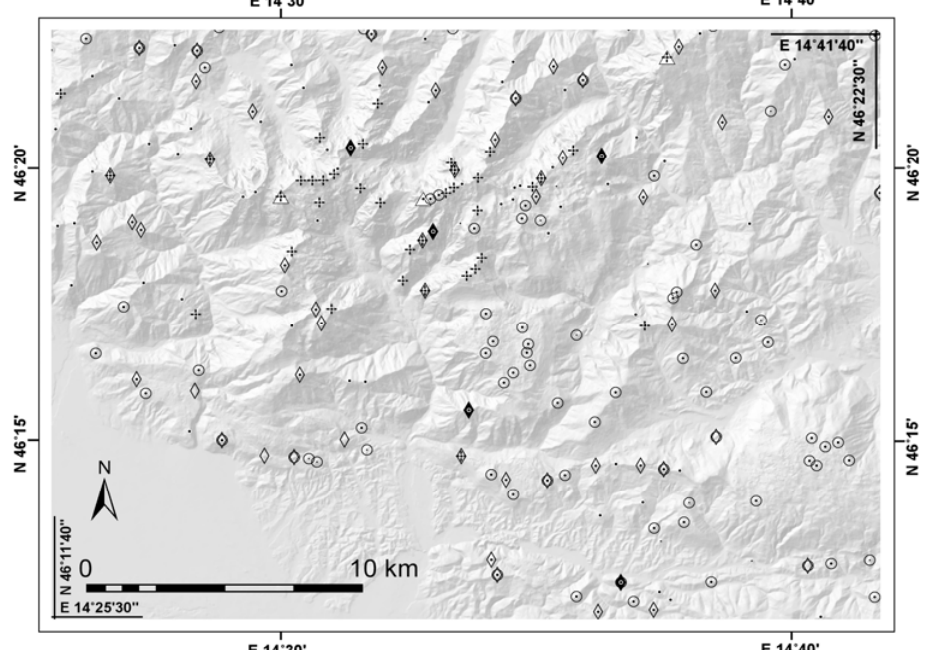
Figure 10. Regional peaks (points) and global peaks (triangular). Additional labels denote the shape of the peaks: crosslet: sharp peak; empty circle: blunt peak; rhombus: oblong peak (a full rhombus denotes a greater degree of oblongness). It can be seen that the sharp and blunt shapes of the peaks cancel each other out, while the oblong shapes can add to each other. Some peaks have not been classified, as their shape is not